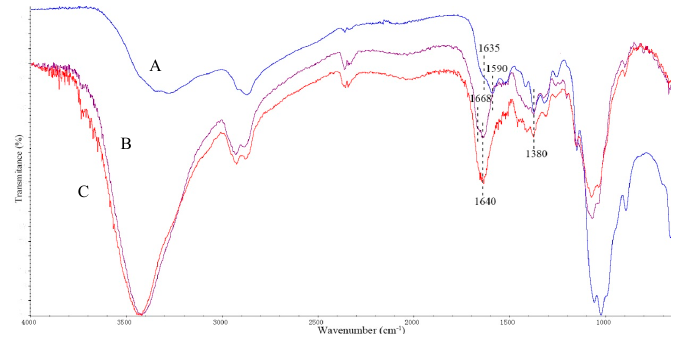
Figure 1. FTIR spectra of ( A ) pure chitosan particles; ( B ) chitosan particles treated with glutaraldehyde; and ( C ) chitosan particles with immobilized SrtA.